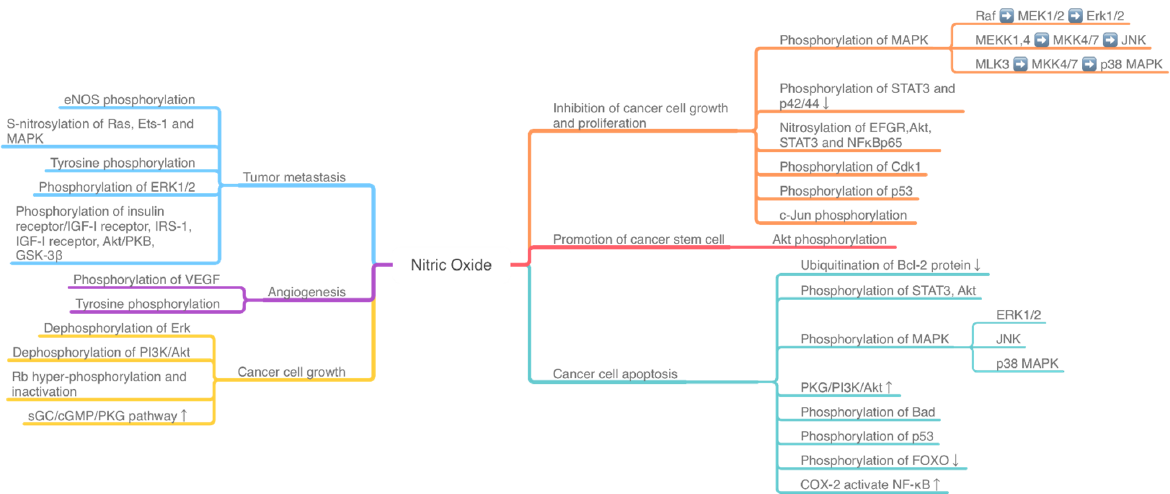
Figure 1. The NO-induced phosphorylation pathway influences the tumor development and death. ERK: extracellular signal-regulated kinase; PI3K: phosphoinositide 3-kinase; MAPK: mitogen-activated protein kinases; MEK: MAPK kinase; MKK: MAPK kinase kinase; ETS-1: E26 avian erythroblastosis virus transcription factor-1; VEGF: vascular endothelial-derived growth factor; JNK: Jun NH2-terminal kinase; Rb: retinoblastoma protein; FOXO: Forkhead box-O; IGF: insulin/insulin-like growth factor; GSK-3β: glycogen synthase kinase-3β.